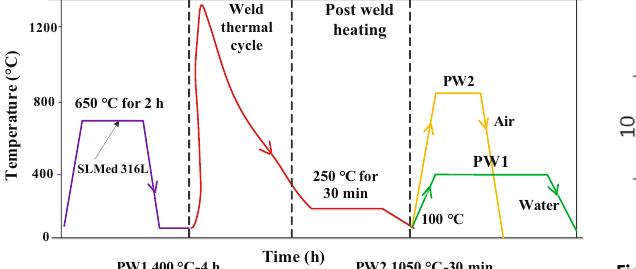
Figure 2: Schematic showing the heat treatment performed on base metal and SLM - 316 L/rolled - 316 L joints.